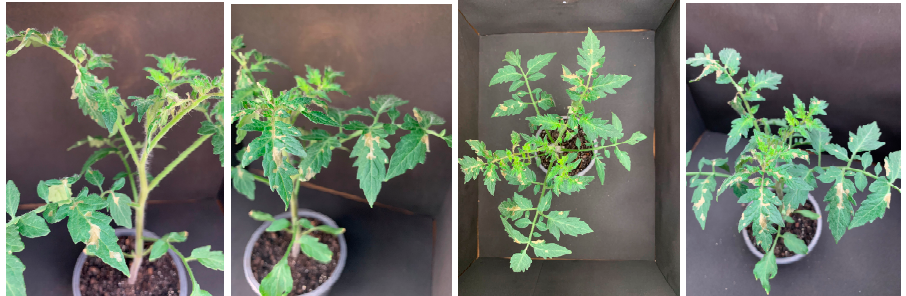
Figure 16. The e ff ects of simulated diquat drift with a close-up view show injuries in tomato plants. 3.6. E ff ects of Simulated Drift Caused by ALS-Inhibiting Herbicides No symptoms were observed in all applied dose ratios due to the simulated nicosul- furon drift in tomato plants (Figure 17). The plants developed normally, similar to the control treatment, as shown in Figure 17.